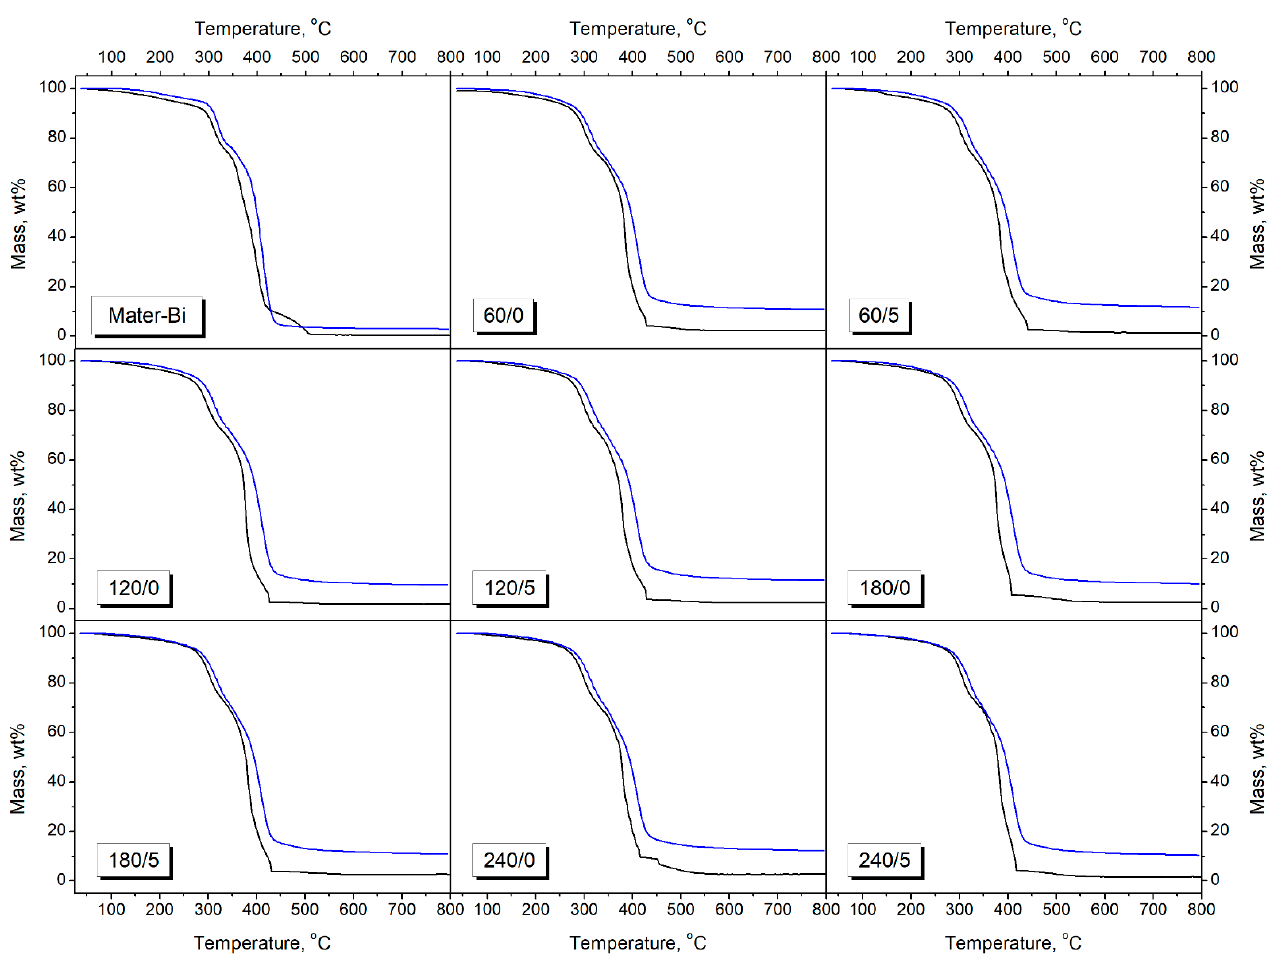
Figure 3. TGA curves registered for Mater-Bi and its composites (upper blue curves registered in N 2 and lower black curves in O 2 ).